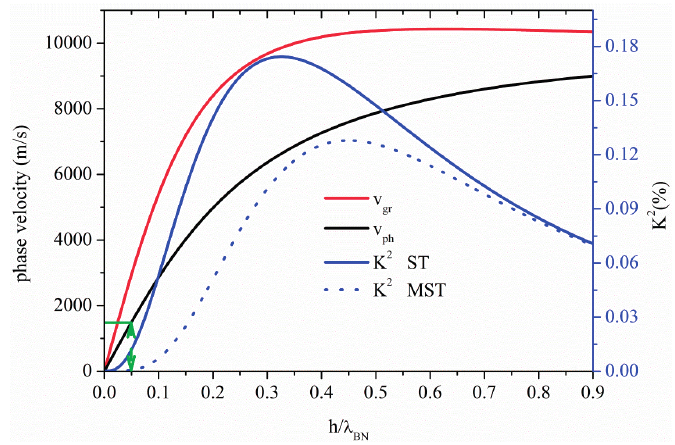
Figure 5. Phase and group velocity, and K 2 dispersion curves of the A 0 mode propagating along the MST and ST configurations on BN